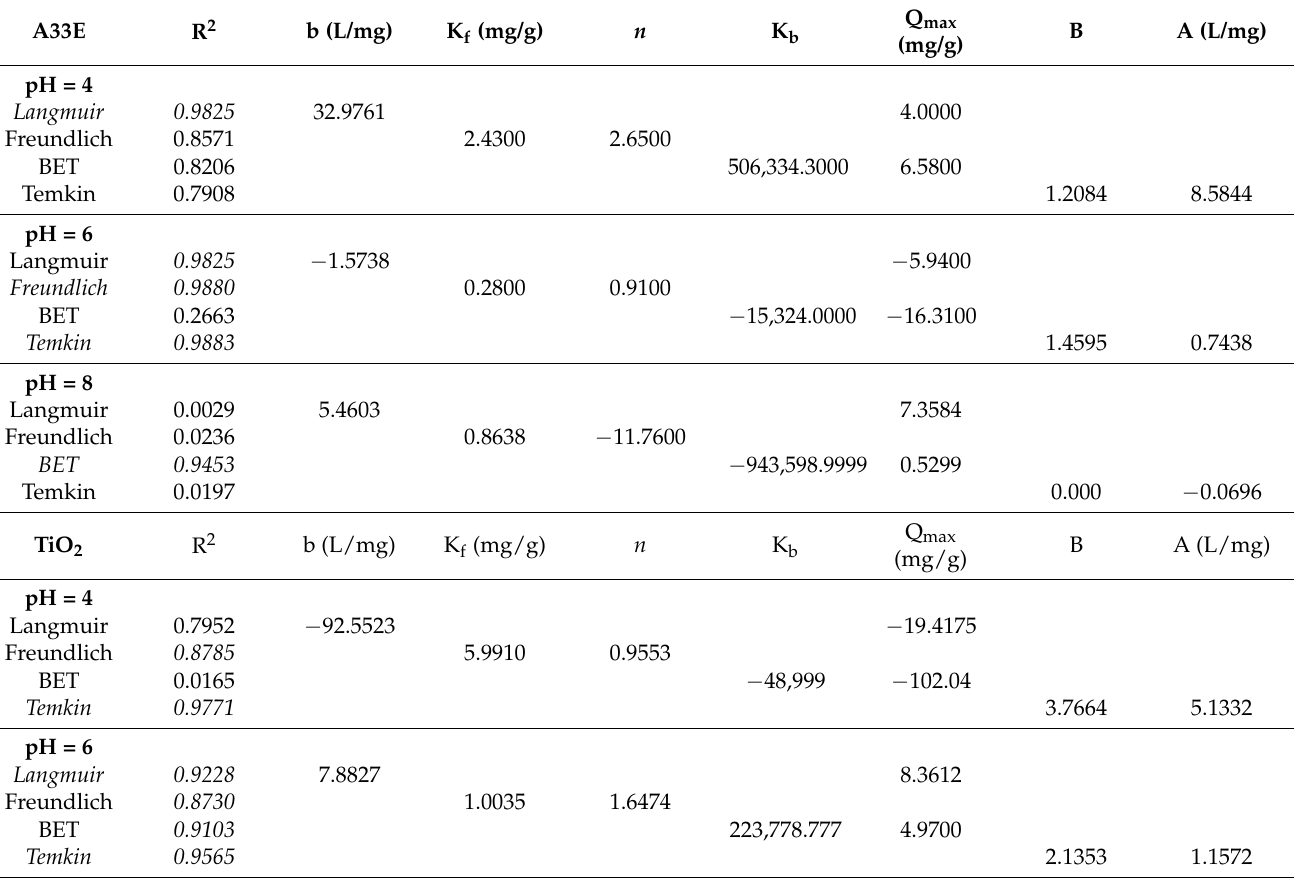
Table 8. Significant parameters related to the various isotherm models for fixed pH at